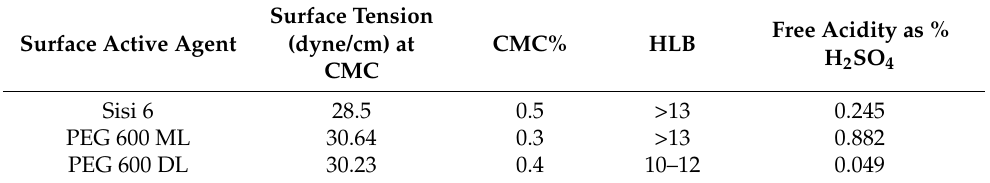
Table 2. Physicochemical characteristics of surfactants used for preparing phenol as soluble concentrates.